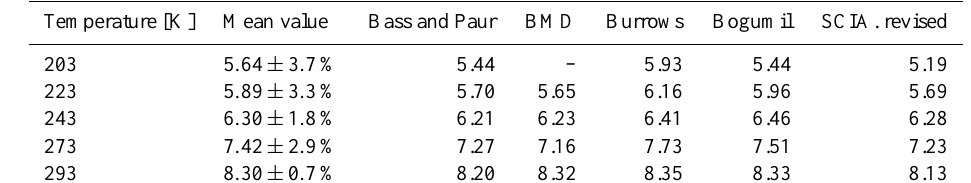
Table 2. Comparison of integrated cross sections in the Huggins band (325–340nm) in units of 10 − 20 cm 2 nmmolecule − 1 . Temperature [K] Mean value